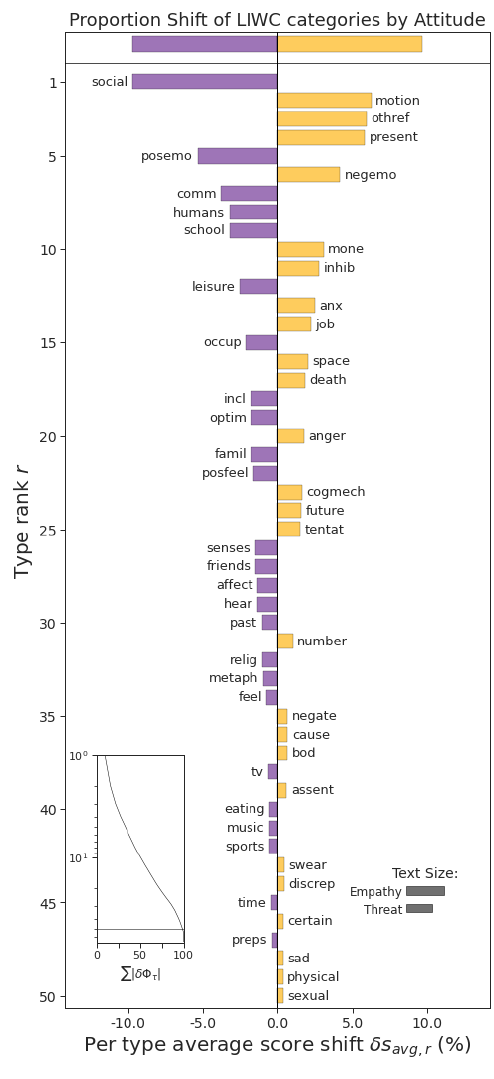
Figure 7. Proportion shift of LIWC categories in tweets grouped by empathy (on the left in purple) and threat (on the right in orange)